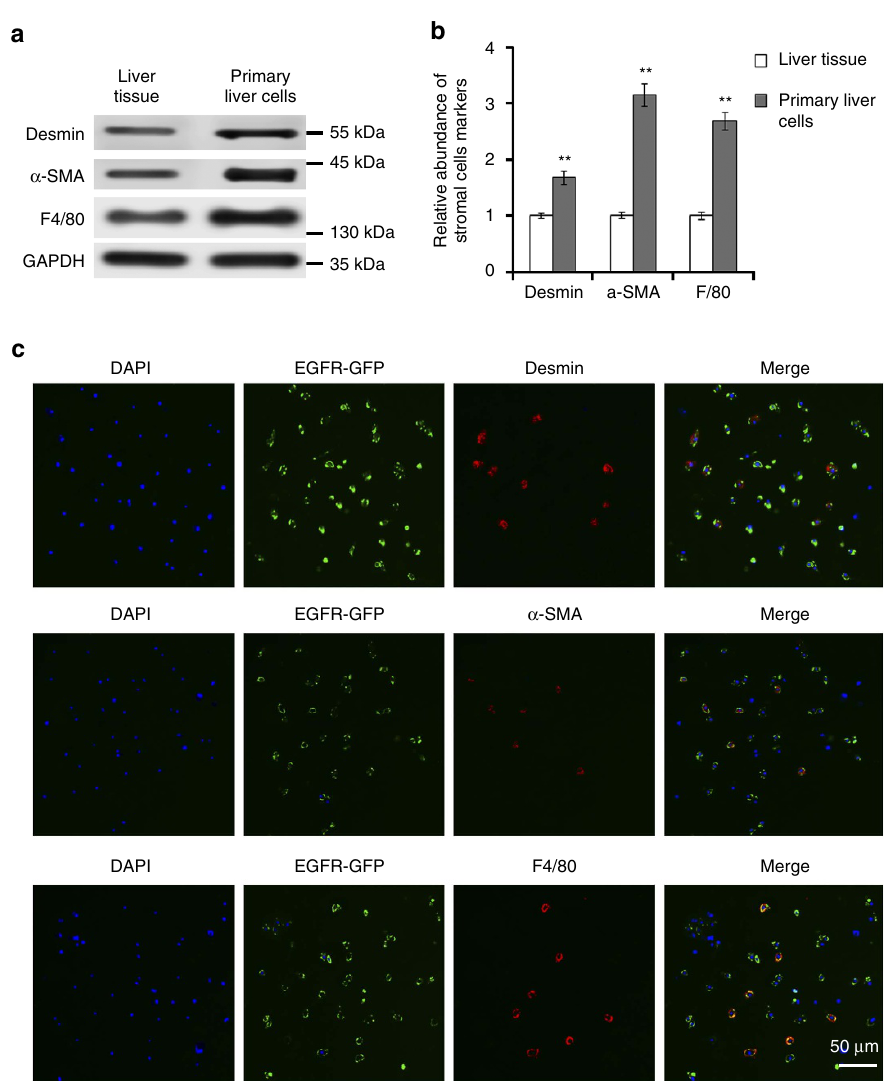
Figure 3 | Characterization of cells types in primary liver cells. ( a ) Western blotting analysis of desmin, a -SMA and F4/80 in mixed primary liver cells ( n ¼ 3). ( b ) Quantification analysis of a . ( c ) Immunofluorescence analysis of exosome-delivered EGFR and stromal cell markers. Scale bars, 50 m m. The data represent the mean ± s.e.m. ** P o 0.01 (Student’s t